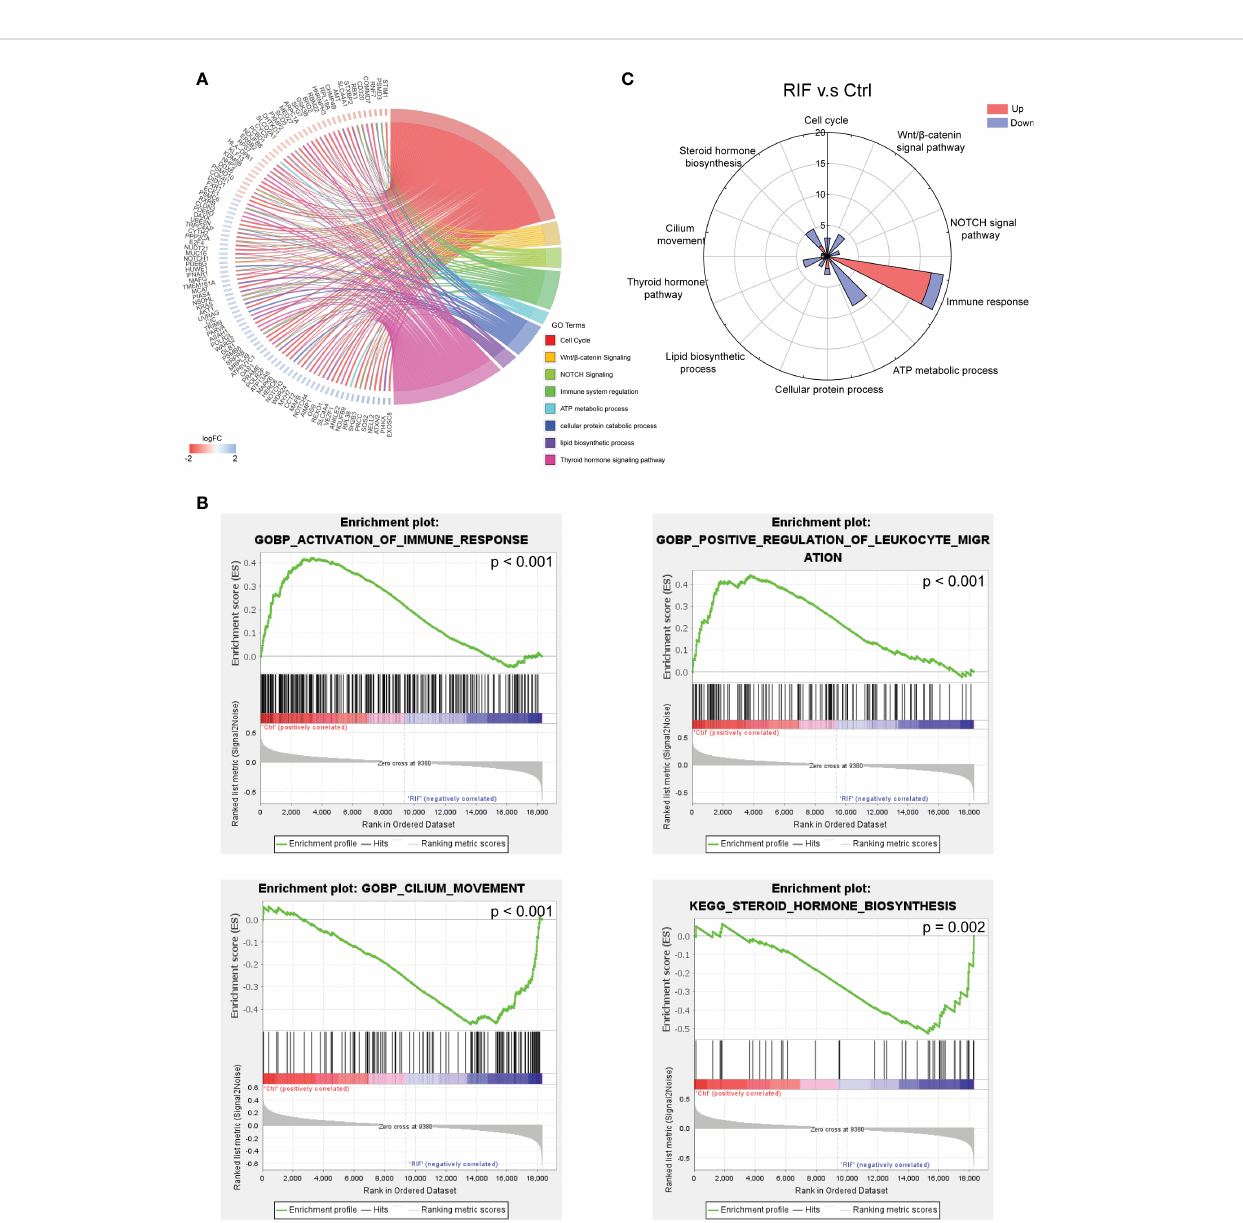
FIGURE 3 Functional Enrichment Analysis of DEGs. (A, B) GO analysis, KEGG pathway analysis (A) , and GSEA enrichment analysis (B) of DEGs. (C) Up or down gene numbers related to cell cycle, signaling by Wnt/ b -catenin, signaling by NOTCH, immune system regulation, ATP metabolic process, cellular protein catabolic process, lipid biosynthetic process, and thyroid hormone signaling pathway in RIF group from validation dataset (GSE183837) were presented by rose